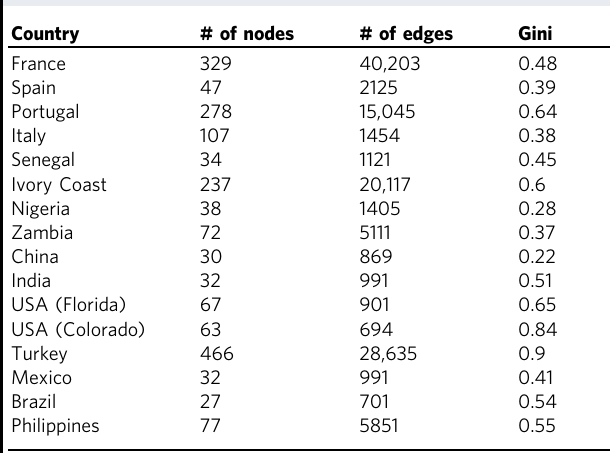
Table 1 Table of the fundamental properties of the networks that appear in Fig.